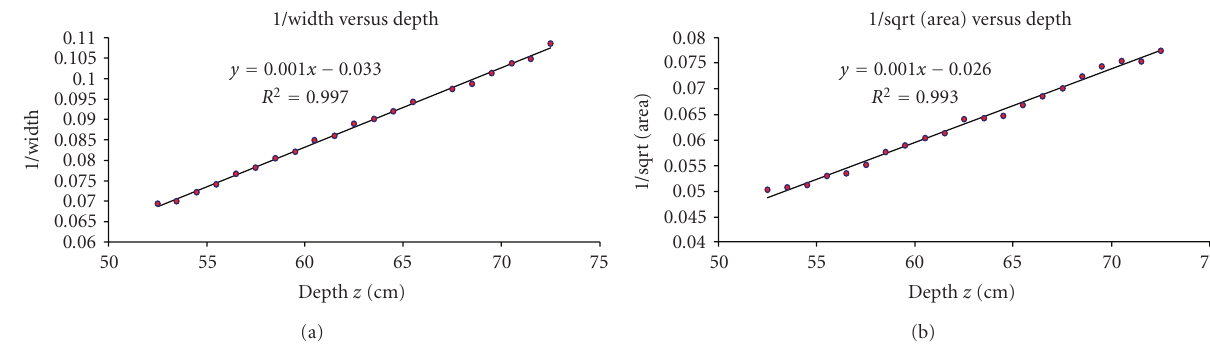
Figure 6: 7-French catheter results. (a) The inverse of the projection electrode-tip width versus depth and (b) the inverse of the projection area versus depth using a single-view image.